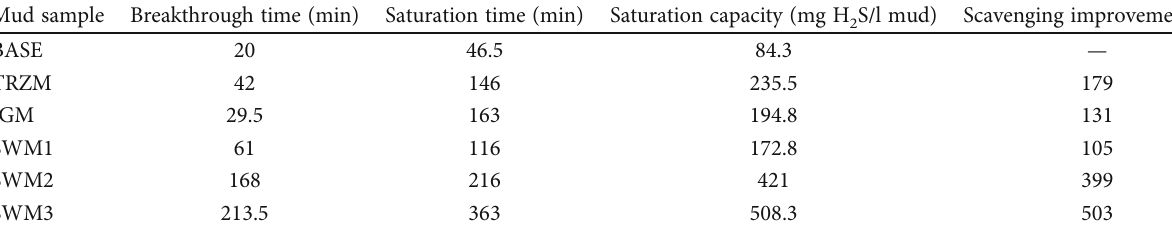
S scavenging experiments. 2